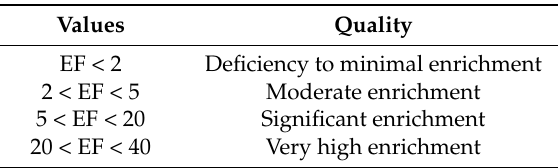
Table 2. Enrichment factor